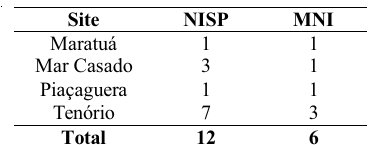
Table 2 . Element frequencies of sawfish identified from shell mounds.